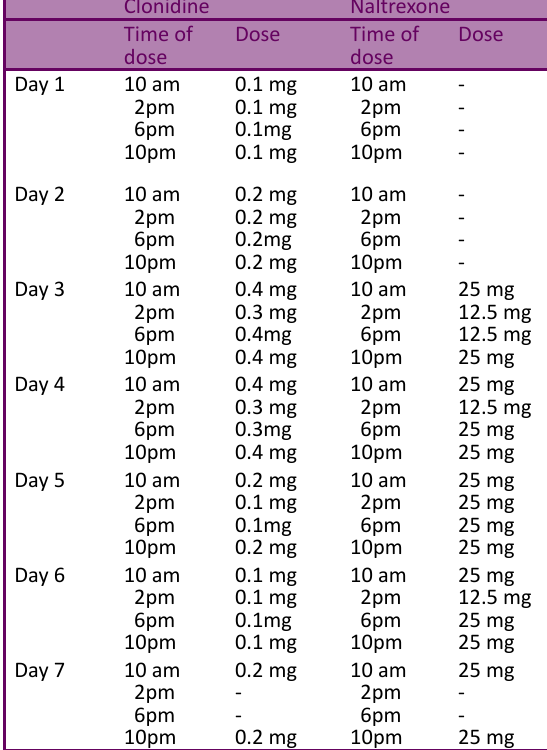
Table 1 -Comparison of mean scores between